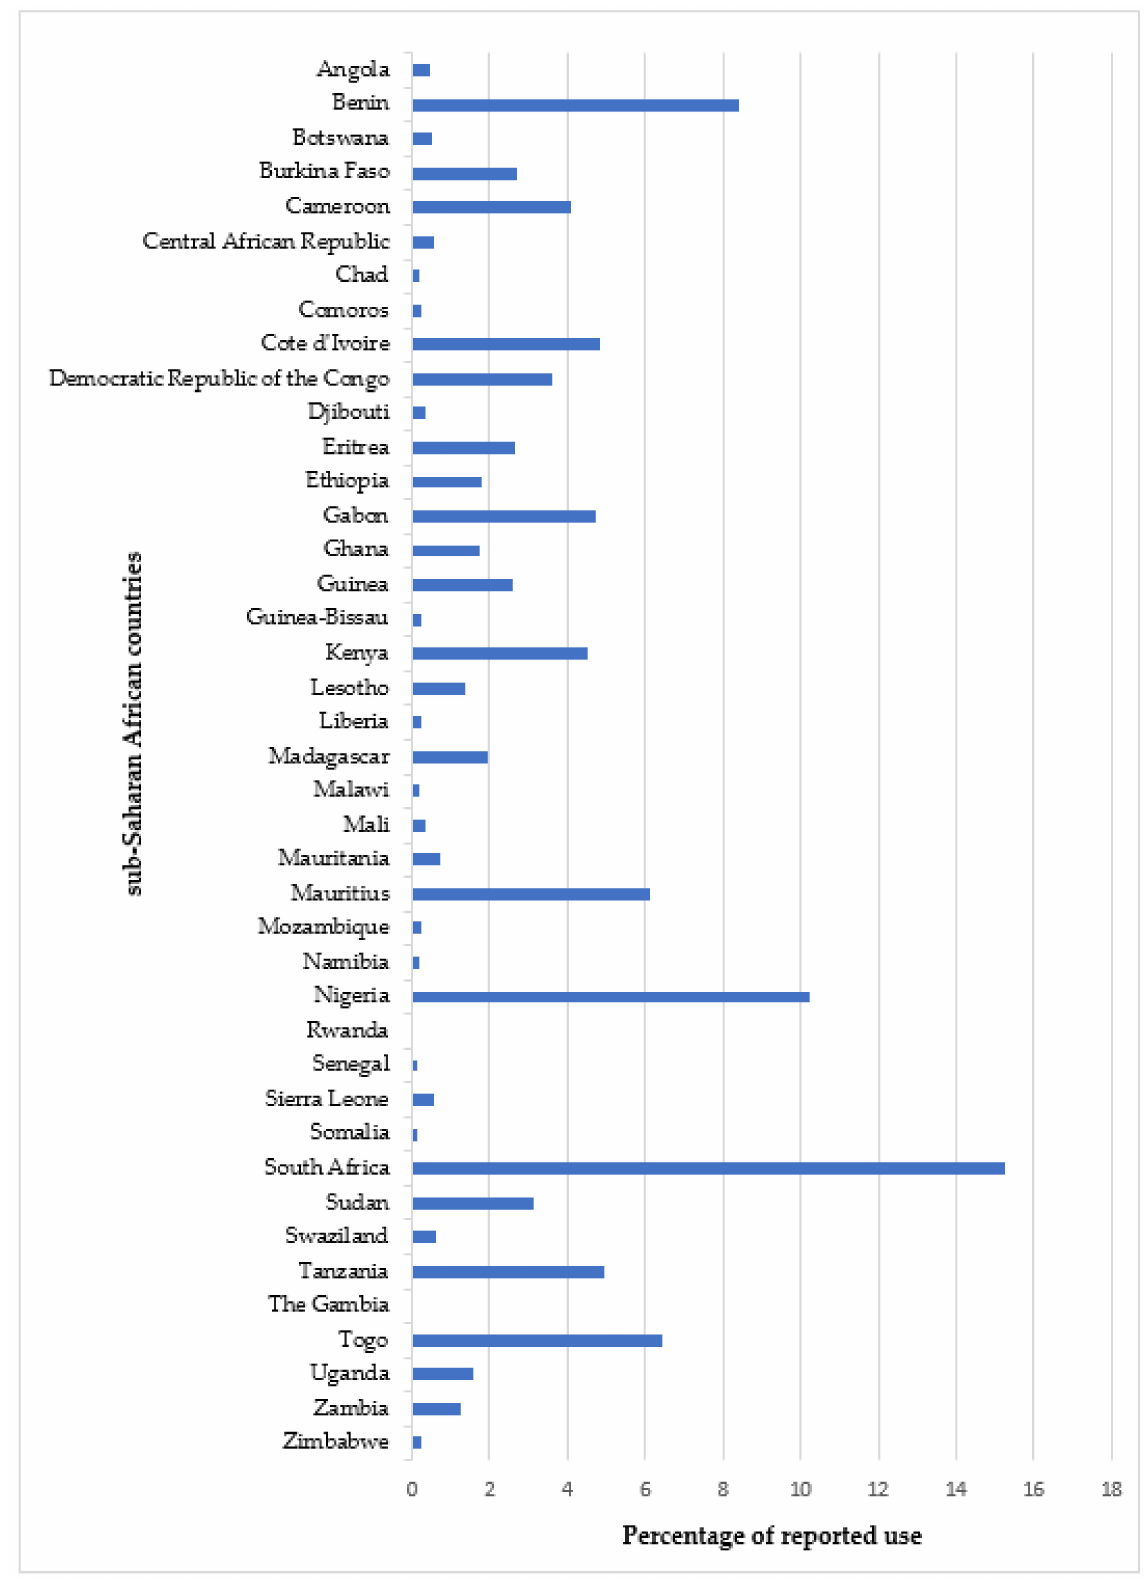
Figure 7. Percentage of reported use of medicinal plants for cardiovascular diseases treatment in each of the sub-Saharan African